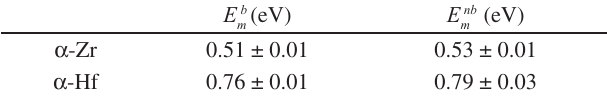
Table 3. Vacancy migration energy calculated from the jump frequency evalu- ated by molecular dynamic.